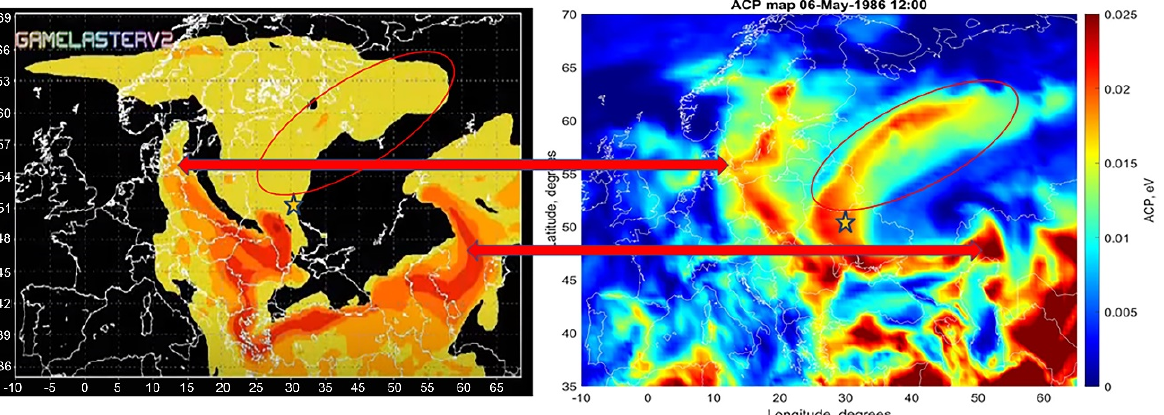
Figure 6. Left panel—spatial distribution of cesium-137 on 6 May 1986 at 12:00 UTC; right panel— spatial distribution of ACP on 06 May 1986 at 12:00 UTC. Asterisks show the position of Chernobyl NPP, arrows and ovals show similarities of distributions